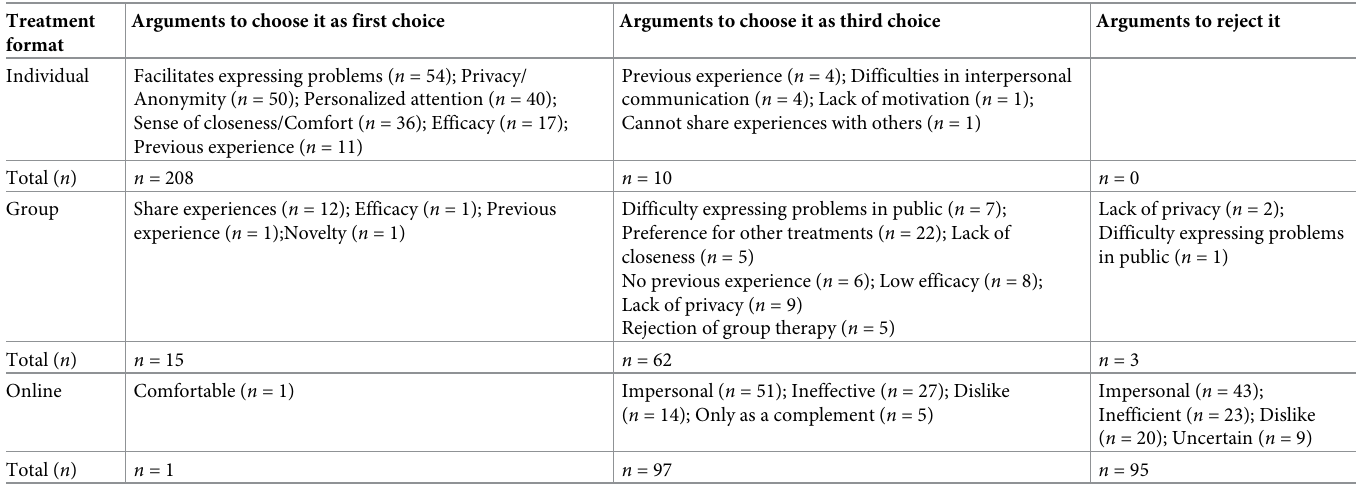
Table 4. Arguments for and against treatment format